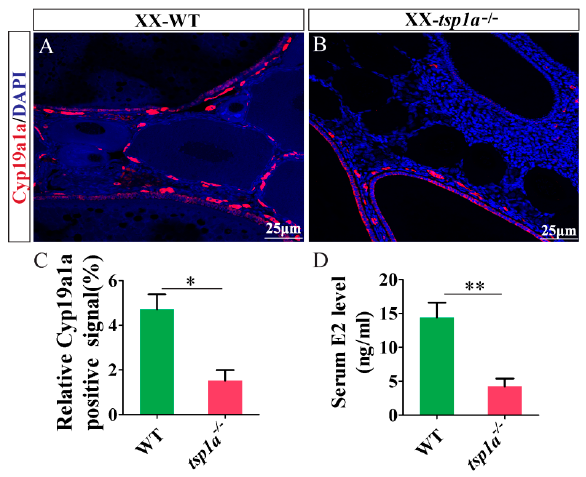
Figure 6. Down-regulation of Cyp19a1a expression and serum E2 level in tsp1a − / − ovaries in comparison with WT ovaries at 180 dah. (A , B ) Immunofluorescence analysis. Red fluorescence represents the Cyp19a1a signal. Blue fluorescence represents the DAPI signal. ( C ) The statistical analysis of the positive signals ( n = 5, and five sections for per sample were counted). ( D ) Serum E2 EIA analysis ( n = 5). Differences between the mutants and WT were tested by two-tailed unpaired Student’s t-test, * P < 0.05; ** P < 0.01. Results were presented as the mean ± SD in C and D. 3. Discussion In mammals, TSP1 was expressed in a wide range of tissues examined including granulosa cells of the ovaries, lung, skeletal muscle and so on [22–24], while the role of TSP1 in the ovaries remains to be elucidated. In teleosts, two copies of tsp1 ( tsp1a and tsp1b ) were found due to the teleosts specific genome duplication [15]. In Nile tilapia, the expression of tsp1a was detected in the granulosa cells of the ovaries [15]. But the function of tsp1a in teleosts, especially in gonad development, remained to be elucidated. The cellular localization of TSP1 is basically the same in ovaries of mammals. In bovine, TSP1 was reported to be expressed in ovarian granulosa cells and theca cells, with high expression in the small follicles and low expression in the pre-ovulatory follicles [13]. In marmoset, TSP1 was expressed in granulosa cells of secondary, tertiary, pre-ovulatory, and atretic follicles. Expression peaked at the tertiary stage, with reduced expression at the pre-ovulatory stage [14]. In rat, TSP1 showed a similar pattern, with expression in ovarian granulosa cells during the early antral and ovulatory phases [5]. In teleosts, the expression localization of tsp1 mRNA has not been reported except in tilapia. Tsp1 is expressed in the early embryo of zebrafish, but the cellular localization has not been reported [29]. In tilapia, in situ hybridization analysis showed that tsp1a was expressed in ovarian granulosa cells [15]. In the present study, Tsp1a was detected in the oogonia, granulosa cells of phase I to phase IV follicles in the ovaries by using the polyclonal antibody of Tsp1a. Expression of tsp1a mRNA in the ovaries gradually increased during folliculogenesis, with a remarkably increased level at the vitellogenic stage [15]. Similarly, expression of Tsp1a in the granulosa cells was low in the phase I and II follicles, then increased in phase III and IV follicles. Taken together, Tsp1 was expressed in ovarian granulosa cells in mammals as well as in teleosts. These results indicated that Tsp1 may play an important role in ovarian folliculogenesis of vertebrates. Roles of TSP1 in the ovaries of vertebrates were poorly understood. Mice lacking TSP1 was subfertile and exhibited ovarian hyper-vascularization and altered ovarian morphology [21]. In the present study, homozygous mutation of tsp1a resulted in increased oogonia, decreased phase III and